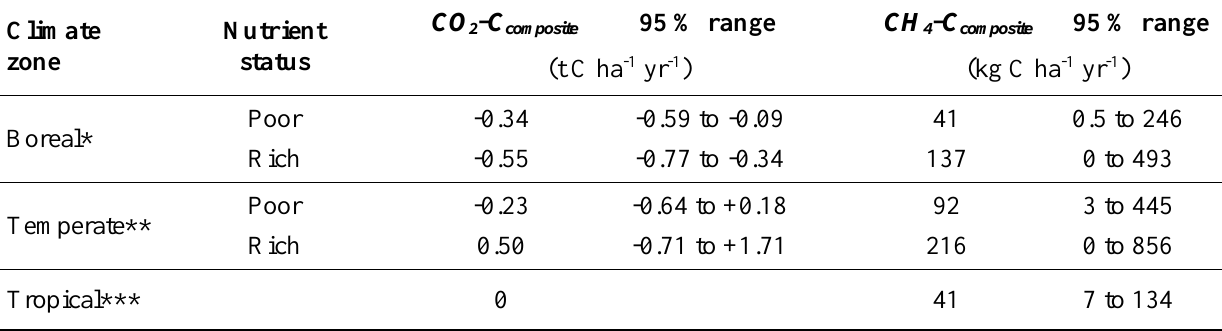
Table 2. Emission factors for carbon dioxide ( CO 2 -C composite : t C ha -1 yr -1 ) and methane ( CH 4 -C composite : kg C ha -1 yr -1 ) in wet organic soils, and associated uncertainty ranges (95 % confidence intervals). Emission factors disaggregated by climate zone and by nutrient status where appropriate. Positive emission factors indicate emissions to the atmosphere and negative values indicate removals from the atmosphere.